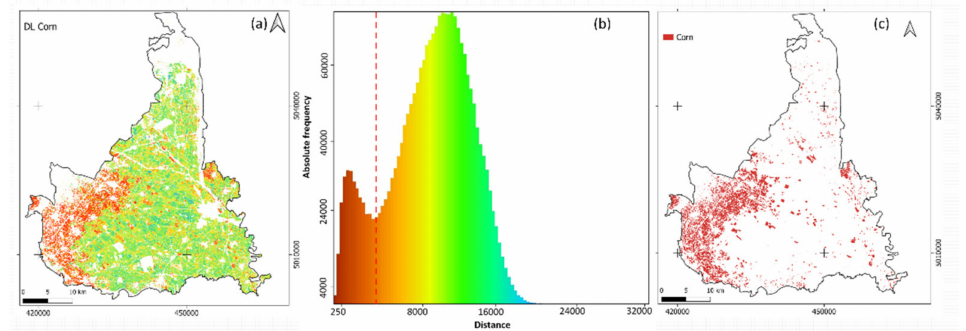
Figure 8. ( a ) DL map of corn. ( b ) Corn DL map frequency histogram. Red line is threshold found by OM. ( c ) Fields classified as corn (reference system is WGS84/UTM 32N, EPSG: